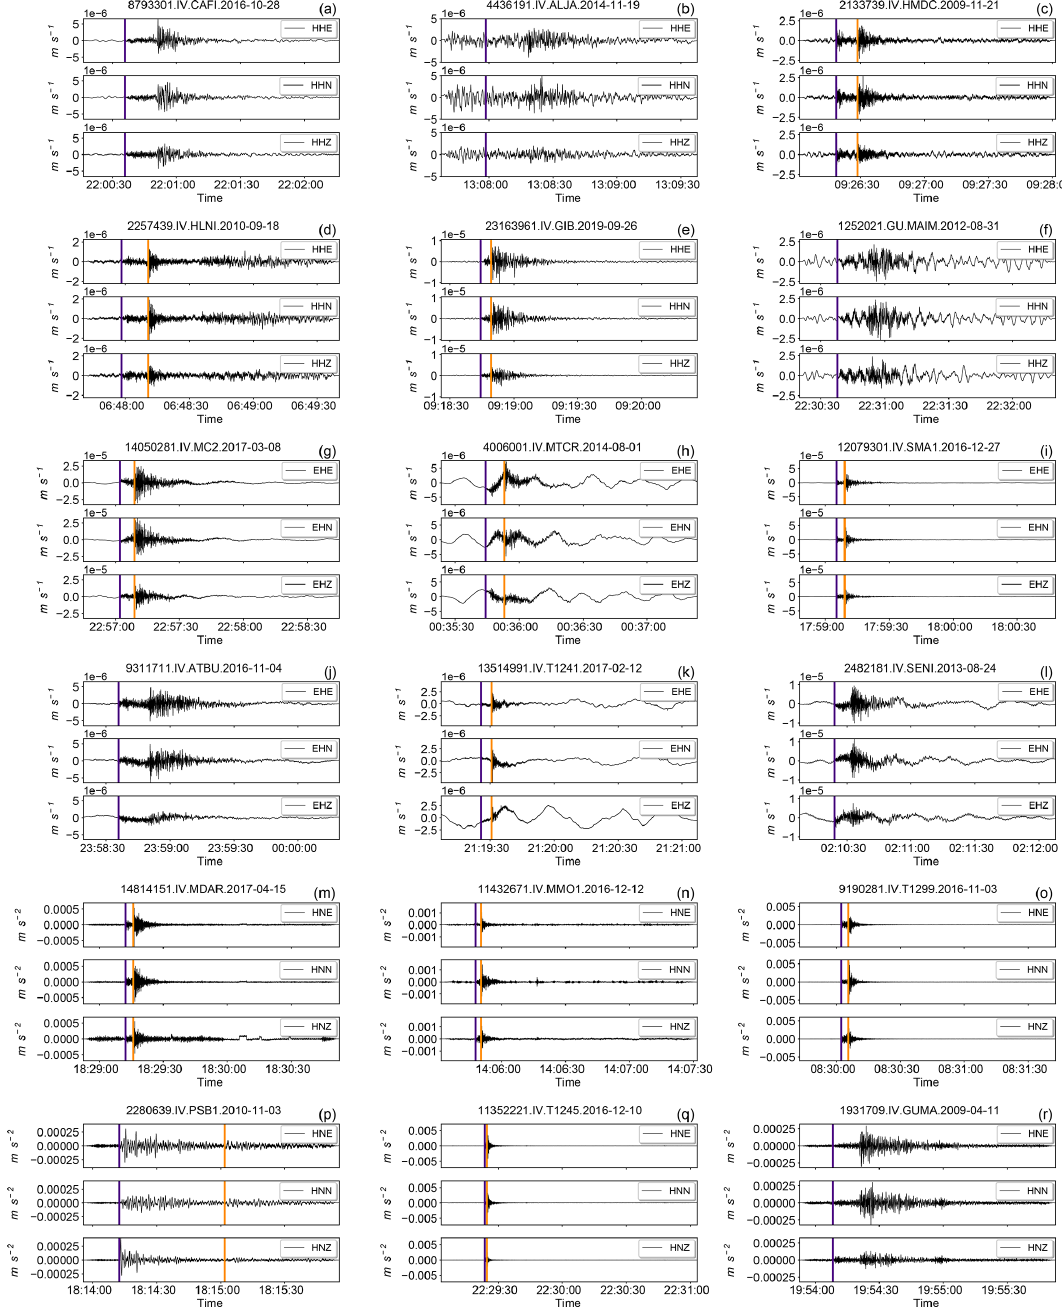
Figure 16. Example of randomly selected event waveforms in ground motion physical units of the HH, EH, and HN channels in INSTANCE. The traces are representative of 75% of the data and belong to the second, third, and fourth quartiles of each channel. Each row contains three, randomly selected, 3C traces drawn according to the following criteria based on the metadata listed in Table 2 and the quantile values provided in Table 4: (a–f) HH traces with trace_pga_perc > 5 . 1 e − 4% g ; (g–l) EH traces with trace_pga_perc > 9 . 3 e − 4% g ; (m–r) HN traces with trace_pga_perc > 8 . 7 e − 4% g . The arrival times of P- and S-wave onsets (i.e., trace_[P,S]_arrival_time ) are shown by indigo and dark orange vertical lines,